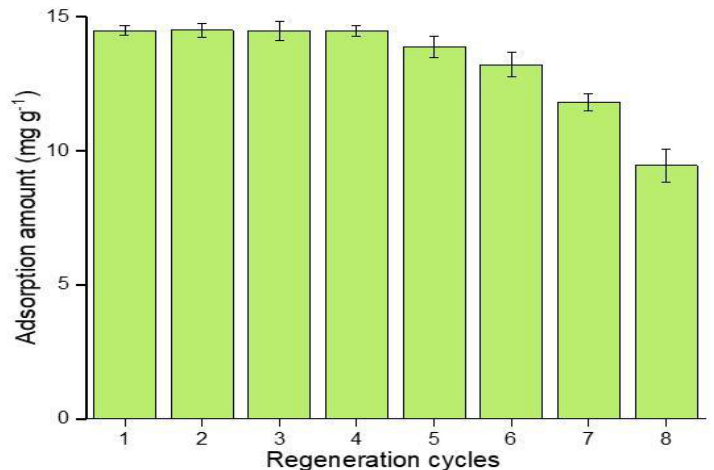
Figure 12. Adsorption recoveries of ABM by M5 in regenerated cycles.